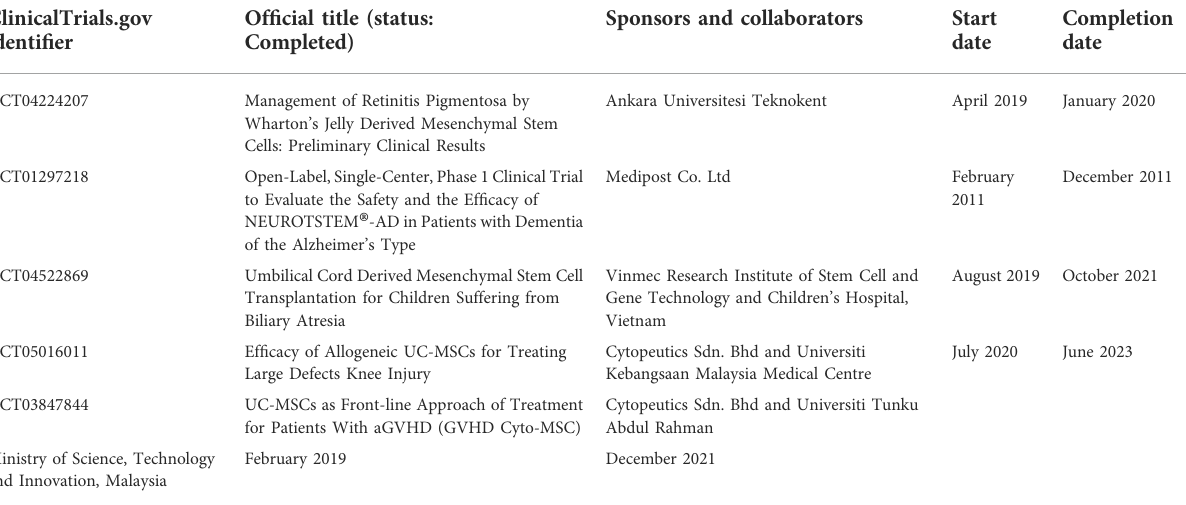
TABLE 3 ( Continued ) Clinical Trials on UC-MSCs recruiting patients from ClinicalTrials.gov.